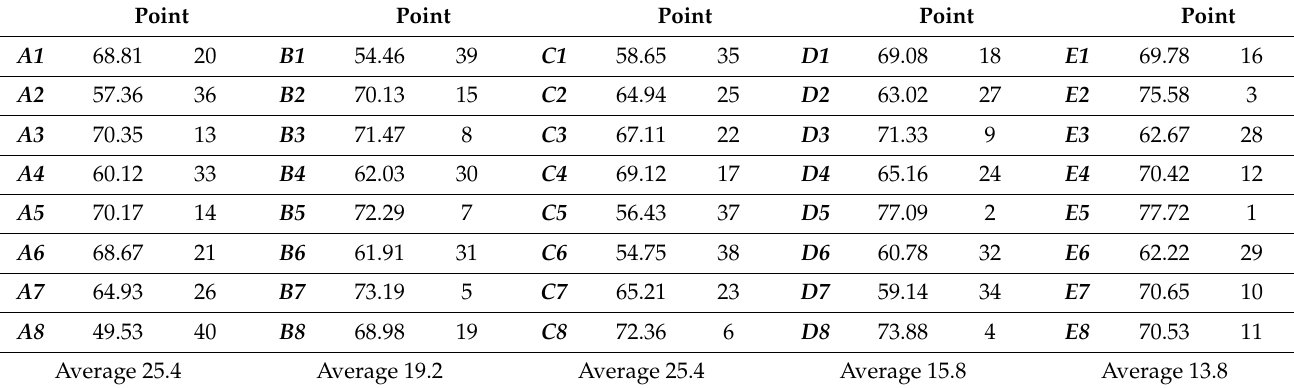
Table 13. Improvement ratio indices on cylinders manufactured with different technologies for S a